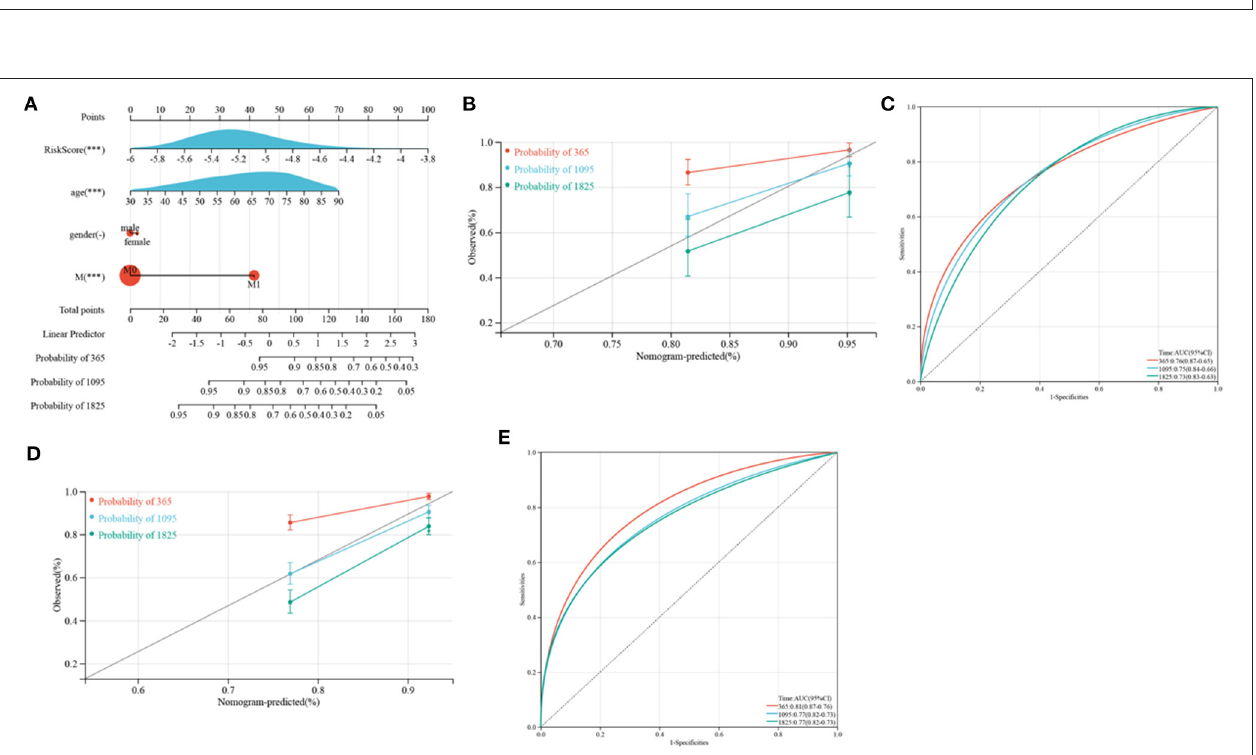
FIGURE 11 | Clinical value of risk signature. (A,C) Forest plots of univariate Cox regression analyses for risk scores and clinical characteristics of patients in the TCGA (A) and GEO (C) cohort. (B,D) Forest plots of multivariate Cox regression analyses for risk scores and clinical characteristics in the TCGA (B) and GEO (D) cohorts.